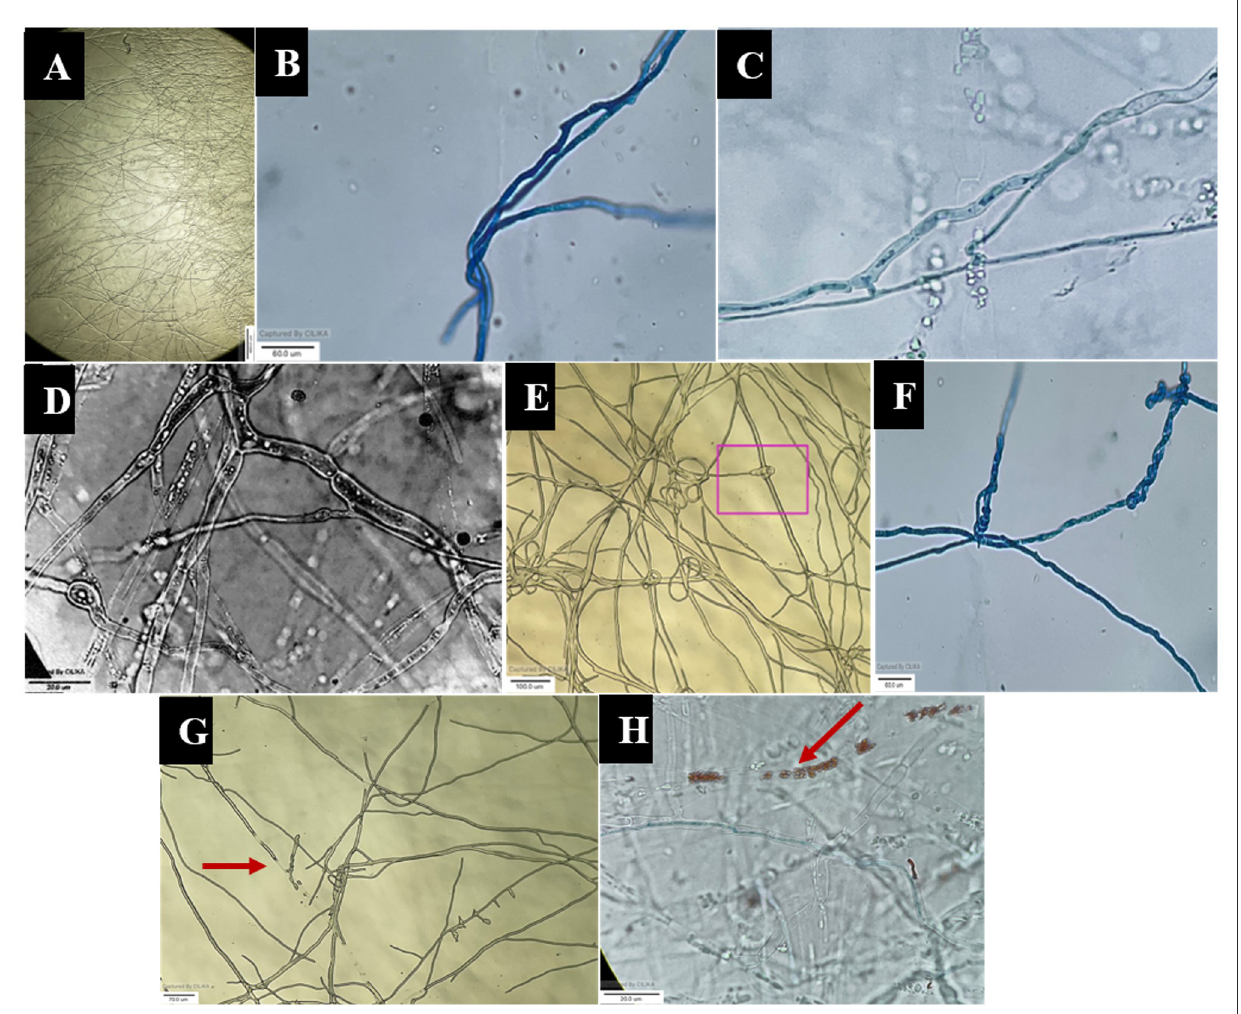
FIGURE6 Microscopic view of mycoparasitic nature of A. niger (AN) on F. oxysporum f. sp. psidii (FOP). (A) Interaction zone; (B) Parallel growing of hyphae of A. niger (AN) to F. oxysporum f. sp. psidii (FOP) hyphae; (C, D) Initial contact and penetration of hyphae forming appressoria-like structure; (E, F) Hook or pincer-like structure (coiling) formed around F. oxysporum f. sp. psidii by A. niger ; (G, H) Red arrow indicates plasmolysis leading to the death of hyphae ( F. oxysporum f. sp. psidii